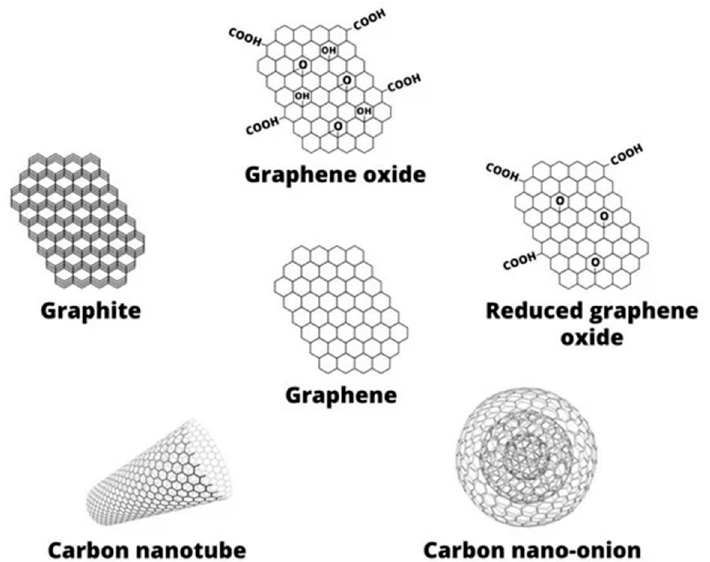
Figure 2. Graphene based materials. Graphene is a basic unit from which other forms of various shapes (nanotubes, onions, etc.) are derived. Graphene oxide and reduced graphene oxide bear oxygen-containing groups such as carboxylic groups (–COOH), hydroxylic groups (–OH), and ether groups (–O–). Graphite consists of individual graphene sheets. Adapted from [33], MDPI, 2019.